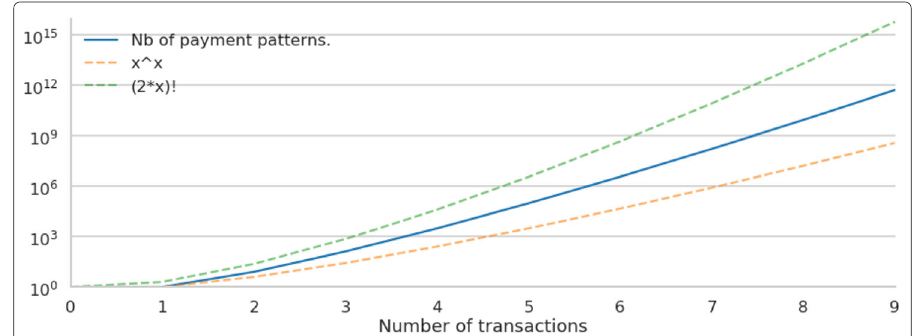
Fig. 5 Number of possible payment patterns when using up to 10 transactions. The possible patterns are computed from the maximum number of possible connections between the vertices of a given set of transactions